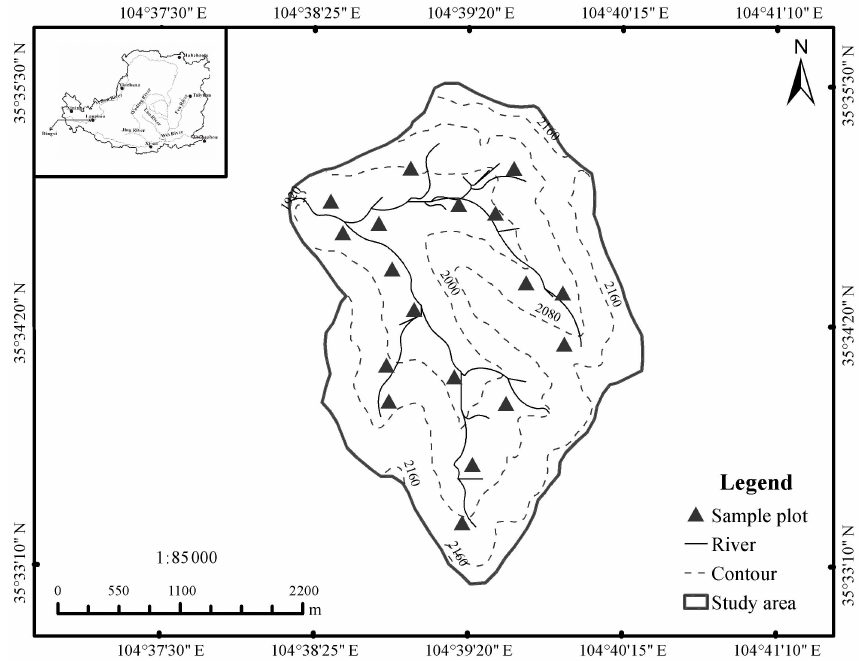
Figure 1. Location of the sampling sites in the study area.